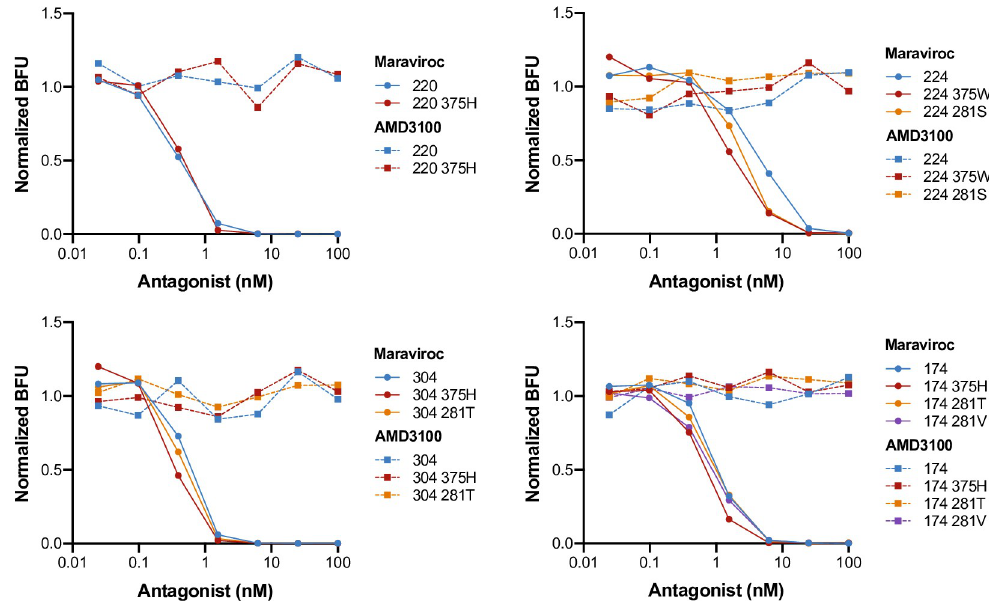
Fig 7. Co-receptor usage of SHIV with 281/375 mutations. Co-receptor usage was assessed for parental and Env281/375 mutant SHIV using a viral entry inhibition assay. Maraviroc, a CCR5 antagonist, and AMD3100, a CXCR4 antagonist, were used in conjunction with TZM-bl reporter cells, which contain a Tat-inducible β -galactosidase gene expression cassette. Blue forming units (BFU) corresponding to infected cells are reported normalized to those with culture lacking Maraviroc and